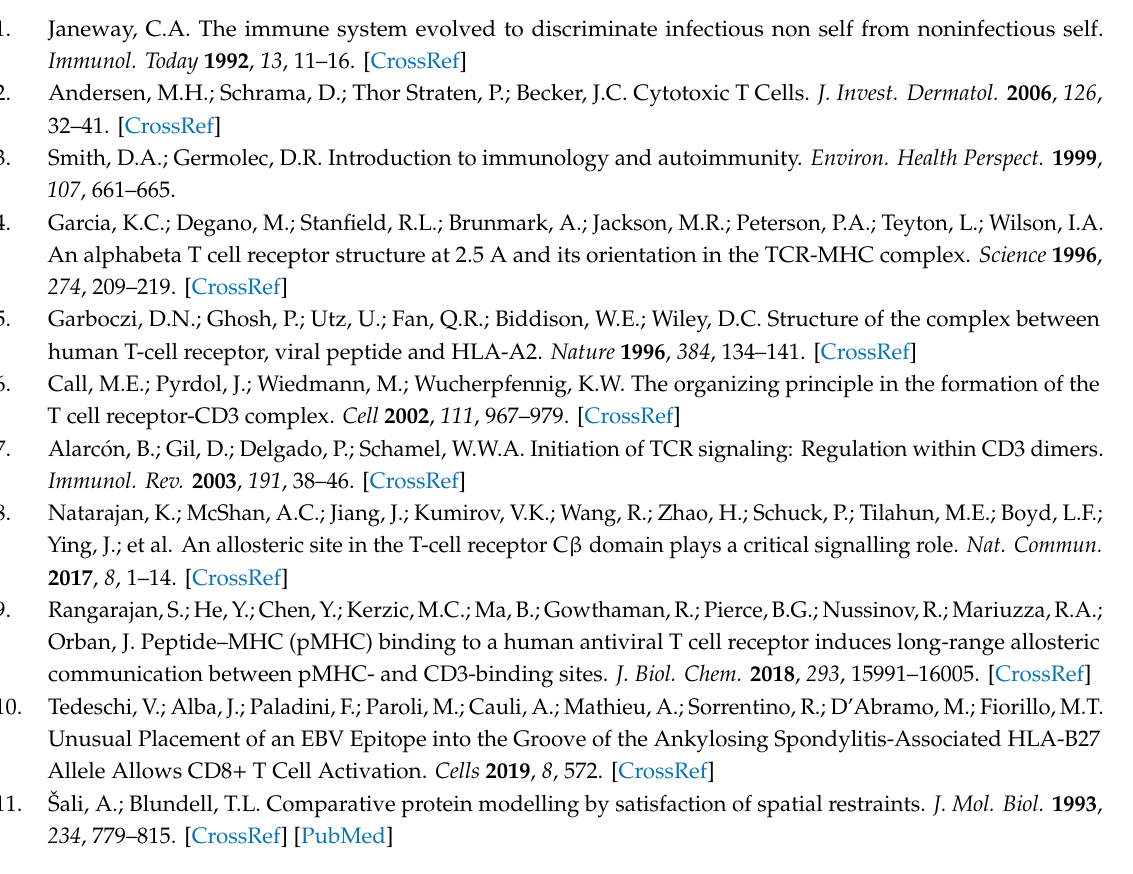
Figure S6: The Zernike Shape similarity of the binding groove, Figure S7: Network analysis, Figure S8: The Zernike pocket electrostatic similarity Figure S9: Membrane Thickness for the 1G4 complexes, Figure S10: Membrane Thickness for the ILA1 / ILA1 α 1 β 1 complexes, Figure S11: Distance between the bilayers, Table S1: The Hydrogen bonds between the peptide and the TCR are shown, Table S2: Peptide Solvent